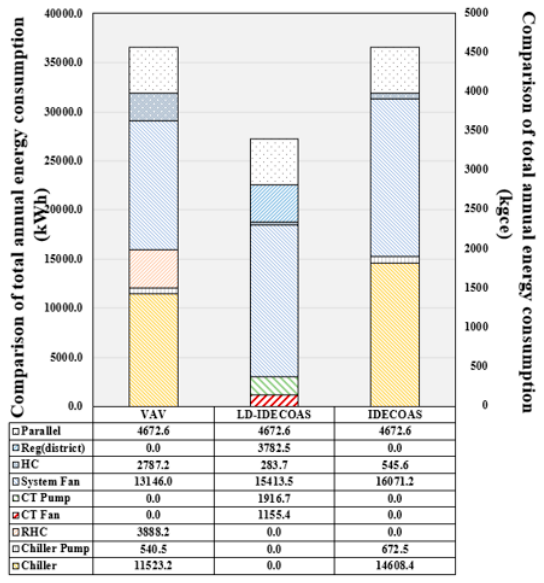
Figure 24. The total annual energy consumption of each system in the Shanghai region.